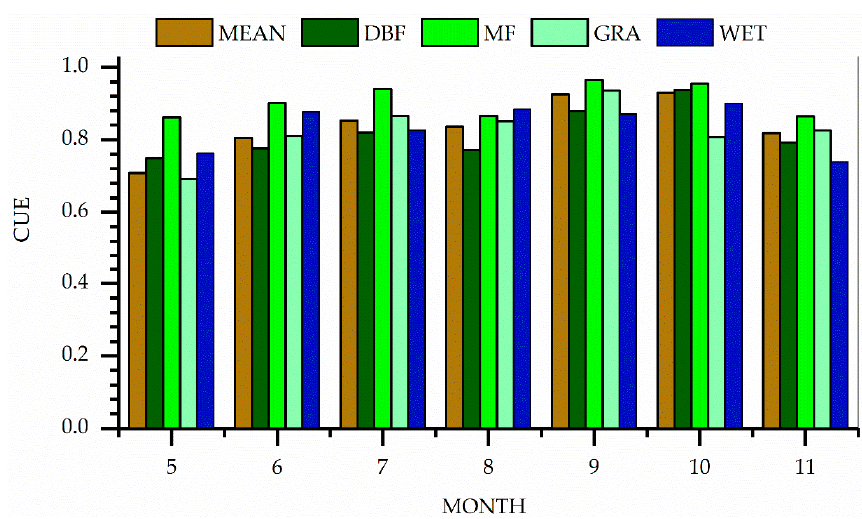
Figure 4. Monthly mean CUE of different ecosystems from 2001 to 2015.